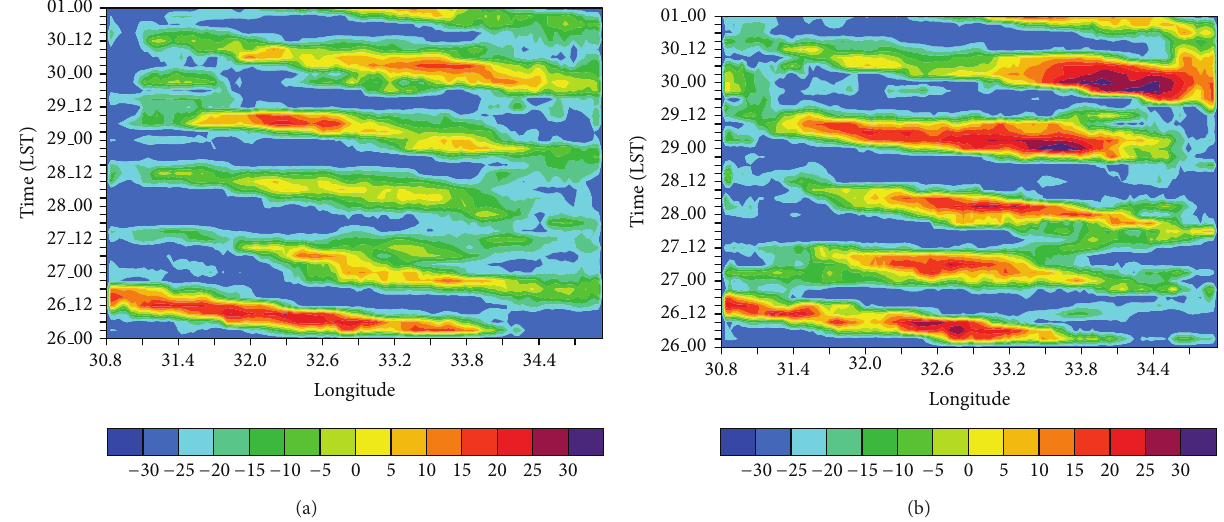
Figure 15: Time-longitude sections of maximum radar reflectivity (in dBZ) over (a) northern and (b) southern parts of the lake.